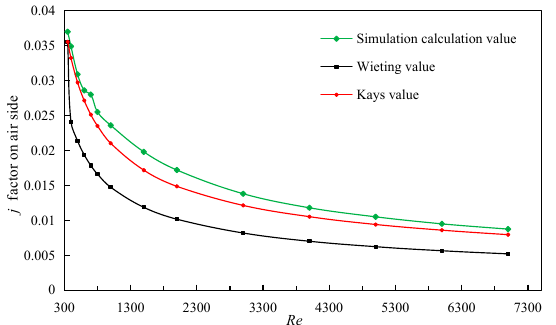
Figure 4. Comparison of j factor on air side.